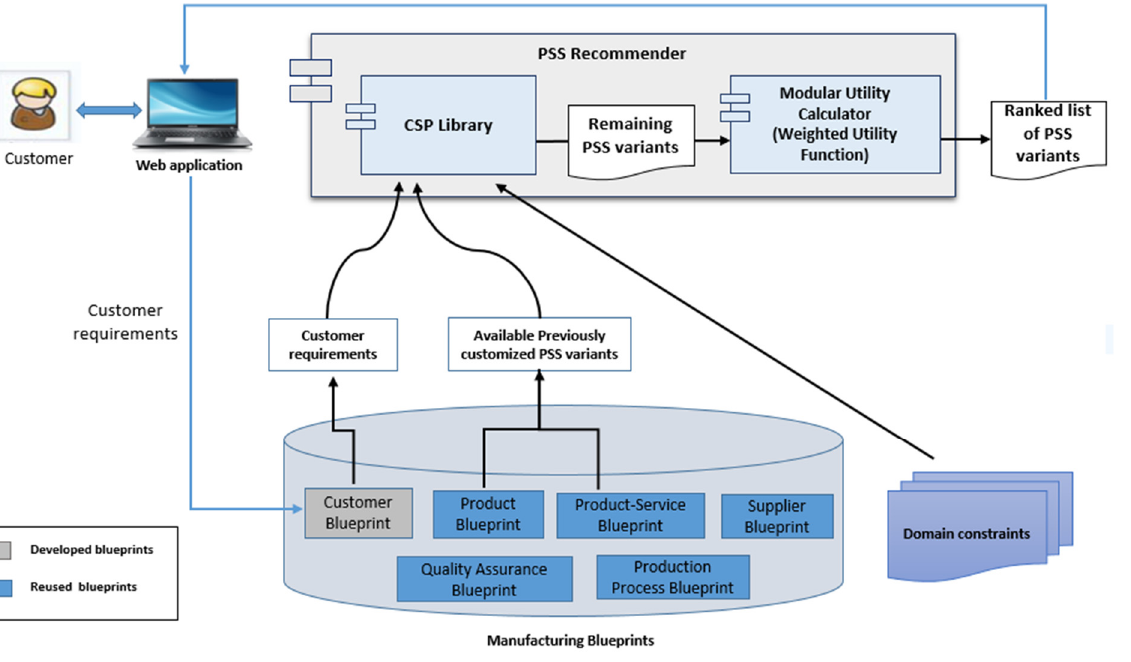
Figure 3. The proposed recommender system architecture.